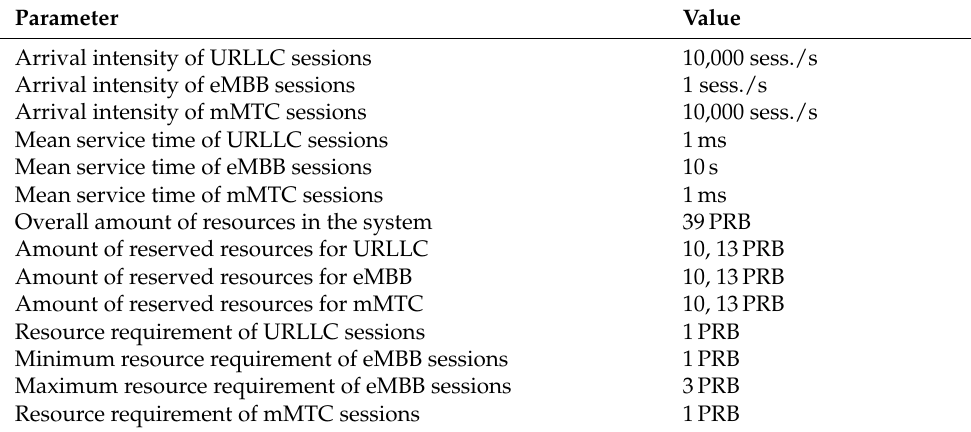
Table 1. Parameters utilized for numerical